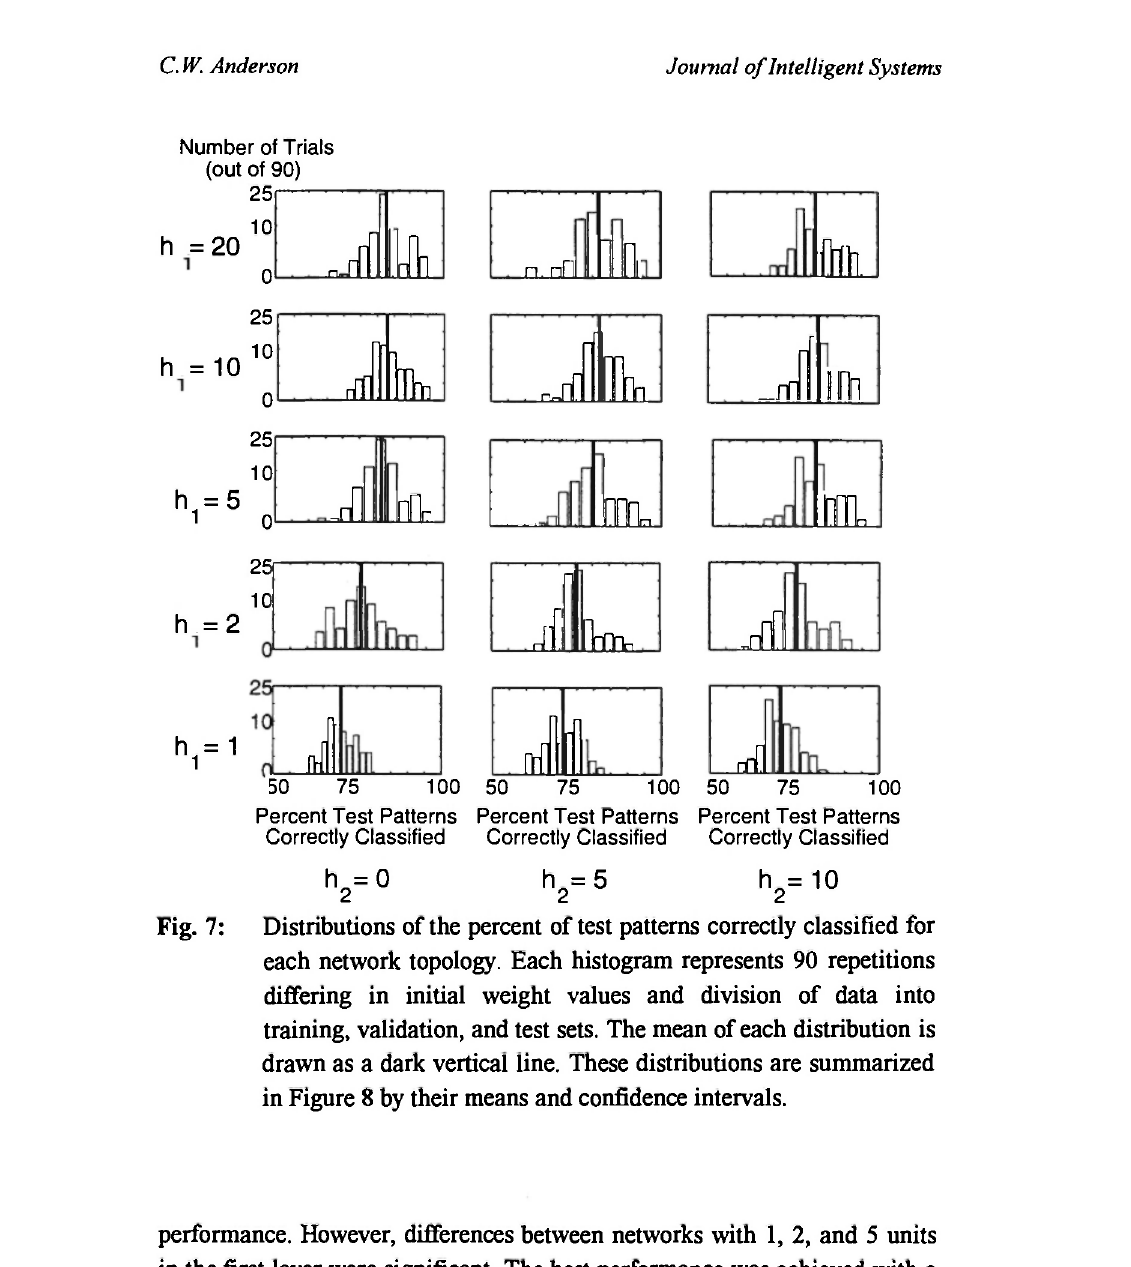
Fig. 7: Distributions of the percent of test patterns correctly classified for each network topology. Each histogram represents 90 repetitions differing in initial weight values and division of data into training, validation, and test sets. The mean of each distribution is drawn as a dark vertical line. These distributions are summarized in Figure 8 by their means and confidence